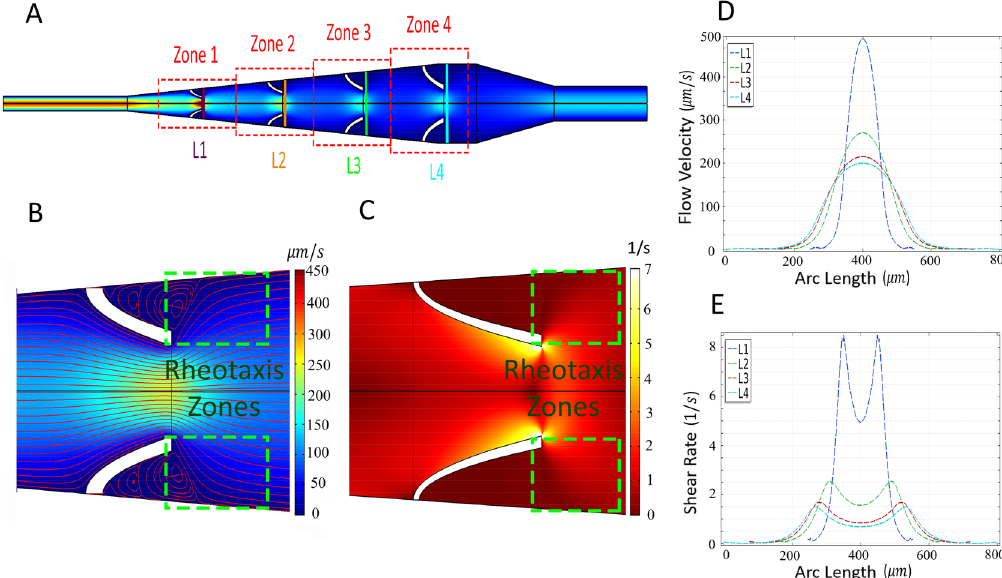
Figure 2. Finite element method simulation results of velocity field and shear rate distribution in the rheotaxis- based sperm separation device at a flow rate of 2 µl/min. ( A ) Velocity field in the device and ( B ) next to the micropockets in Zone 2. Red lines indicate flow streamlines. ( C ) shear rate distribution in Zone 2, indicating a favourable shear rate for sperm rheotaxis near the micropockets. ( D ) Velocity profile and ( E ) shear rate across the microchannel width in each zone and along the lines shown in ( A ).